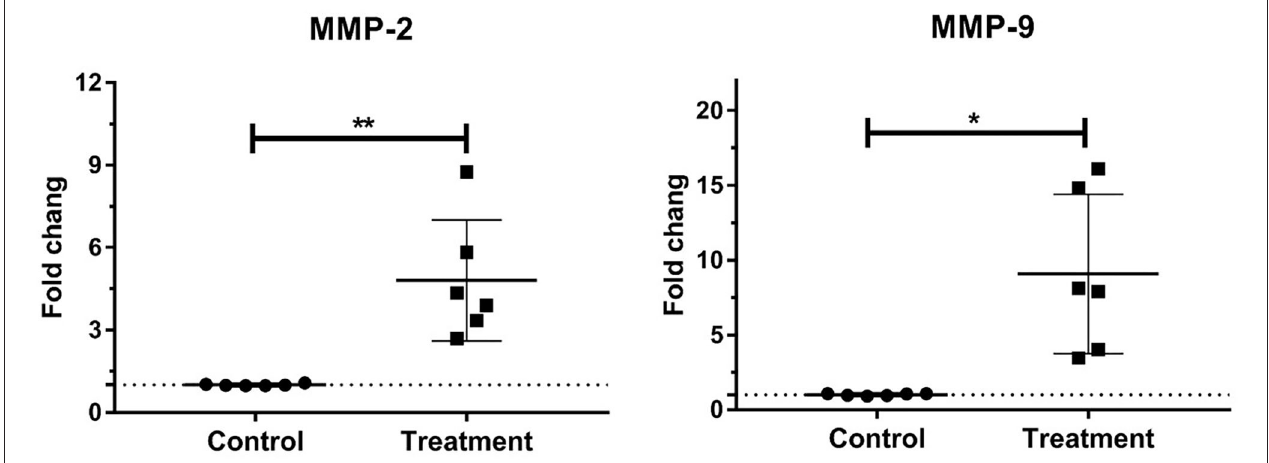
FIGURE 2 | Mean fold changes in MMP-2 and MMP-9 mRNA expression following oligofructose-overload administration in dairy heifers. Significant increases in the treatment group relative to those in the control group, indicated as * P < 0.05 and ** P < 0.01.